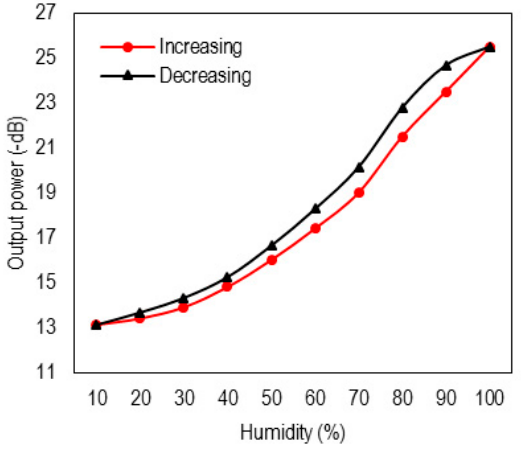
Figure 10. Response of the RH optical sensor when the humidity is decreased and increased in the range of 10%–98%.